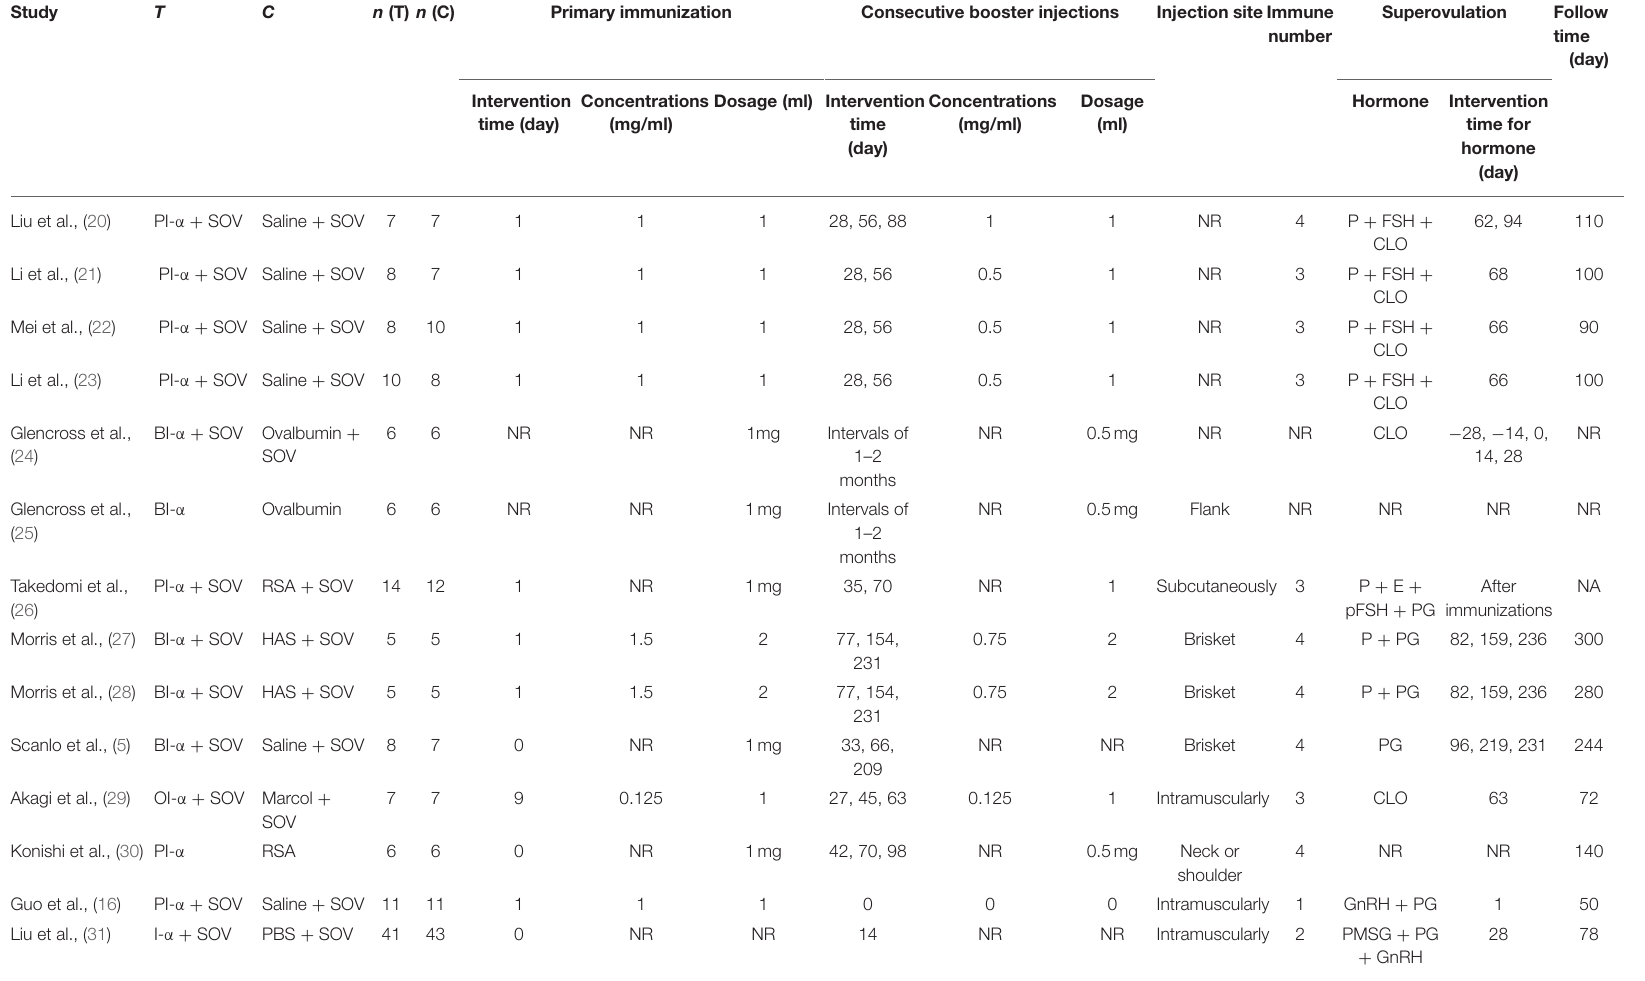
TABLE 2 | Characteristics of inhibin